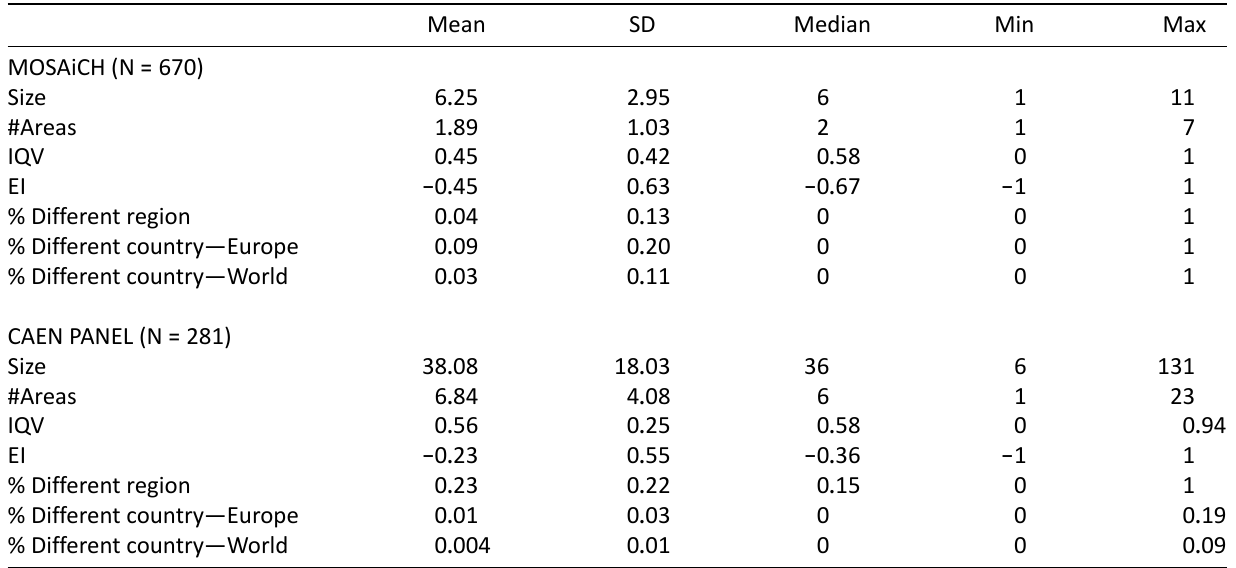
Figure 1. Examples of extreme cases for IQV and EI indices. Table 1. Descriptive statistics of the